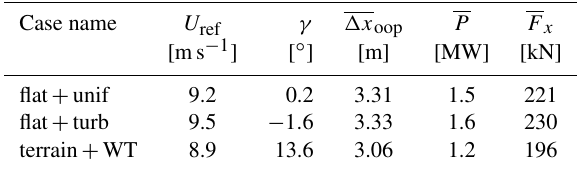
Table 4. Local inflow to the turbine and global loads on the turbine for all simulation cases.